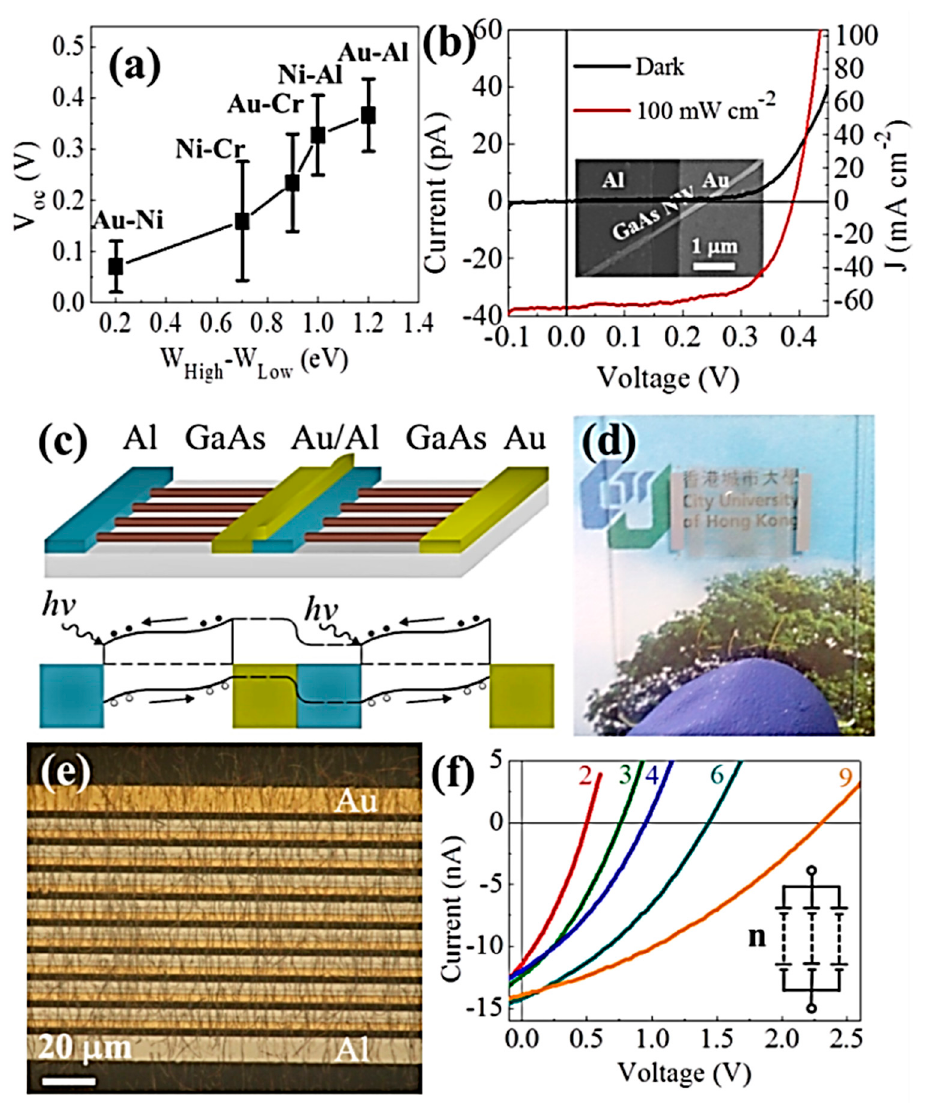
Figure 9. Structure and characteristics of transparent GaAs NW and NW array Schottky photovoltaic devices. ( a ) Open circuit voltage dependence on the work function difference of the asymmetric Schottky electrodes, ( b ) IV curves of one typical GaAs NW PV device, ( c ) schematic of cascaded GaAs NW device structure and band diagram, ( d ) optical microscope image showing a real test tandem (nine-cell connected in parallel) photovoltaic device, ( e ) photograph showing the optical transparency of the NW device constructed on glass, ( f ) I–V curves of the transparent photovoltaic devices composed of two, three, four, six, and nine cells in parallel. Adapted with permission from [81].